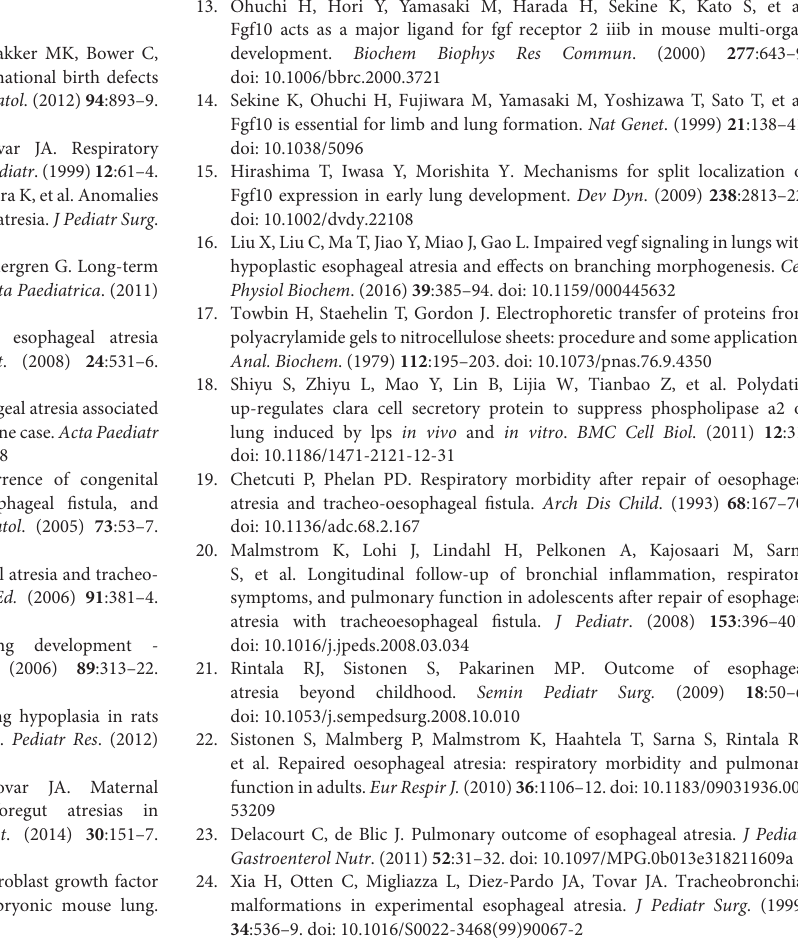
Figure S1 | Esophageal and pulmonary anatomy of esophageal atresia